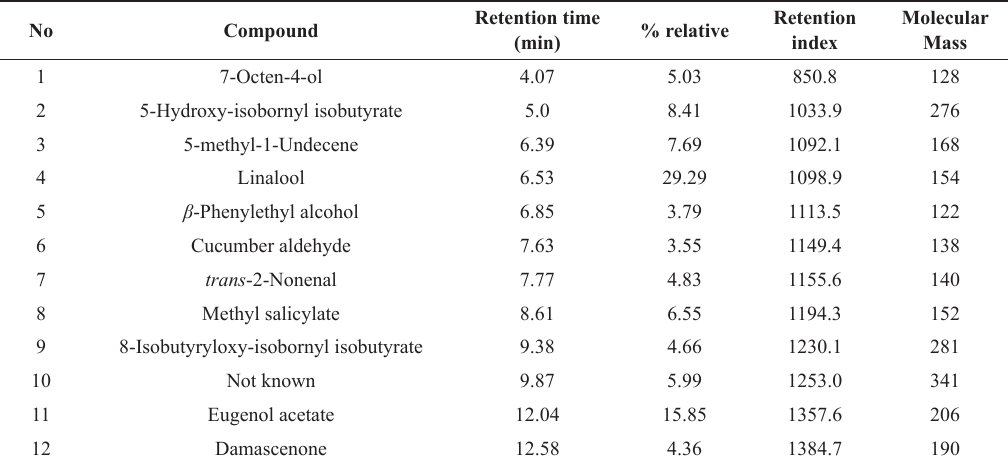
Chemical constituents, retention index and relative concentration of compounds of essential oil of Mitracarpus frigidus analyzed by GC-MS.